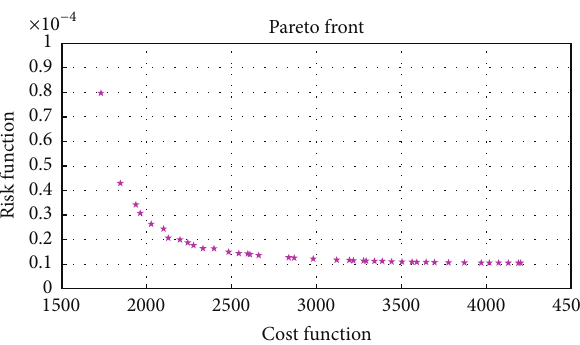
Figure 5: Obtained nondominated solutions with